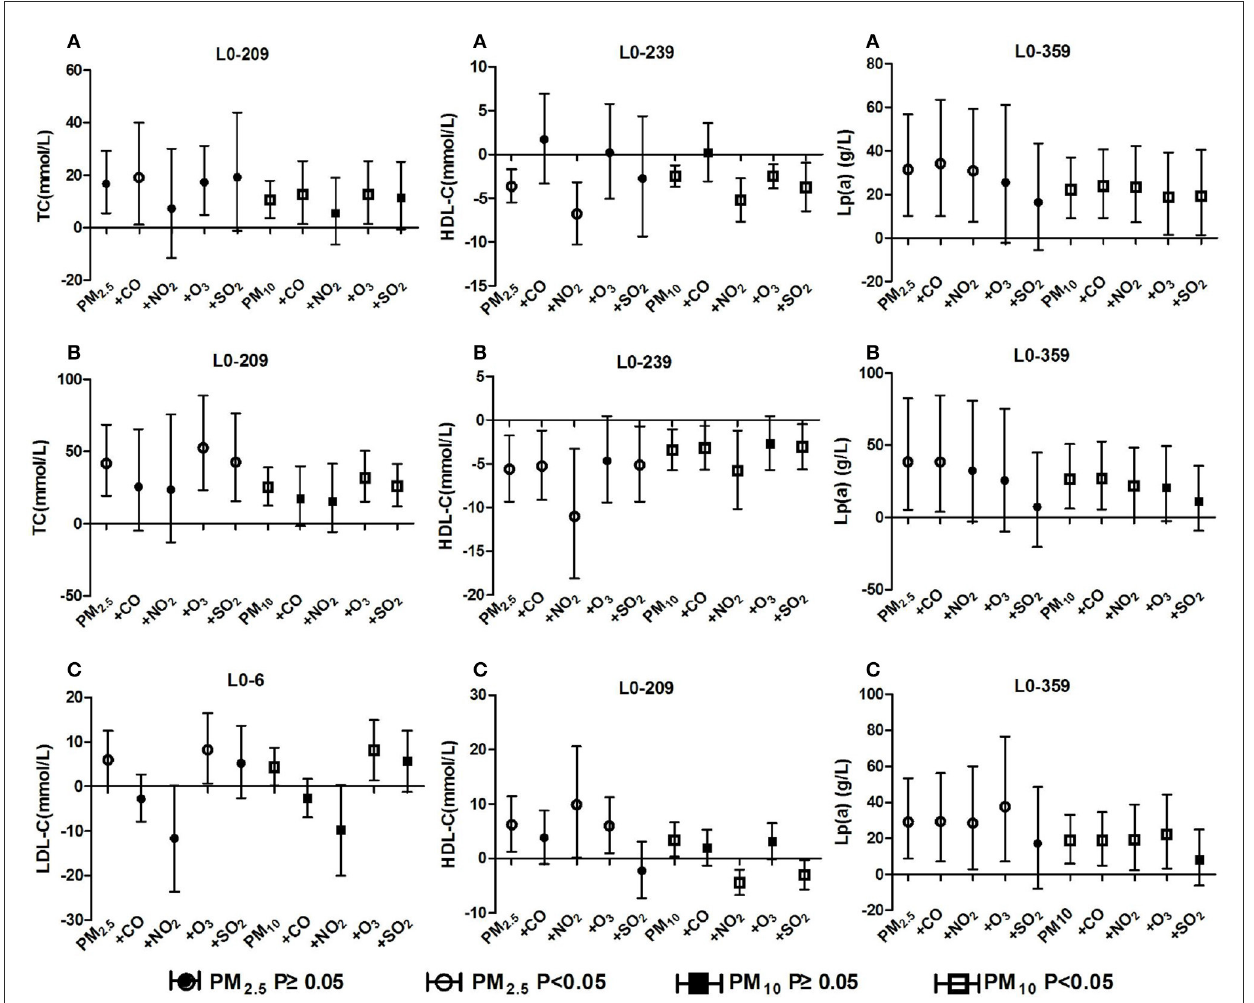
FIGURE6 Effect of ambient particulate matter on blood lipid after adjusting for gaseous pollutants. (A) Effect of ambient particulate matter on blood lipid after adjusting for gaseous pollutants in total hypertensive inpatients, (B) Effect of ambient particulate matter on blood lipid after adjusting for gaseous pollutants in hypertension inpatients with arteriosclerosis, (C) Effect of ambient particulate matter on blood lipid after adjusting for gaseous pollutants in hypertension inpatients without arteriosclerosis. + CO, + NO 2 , + O 3 , + SO 2 two-pollutant model after adjusting for the concentration of CO, NO 2 , O 3 , and SO 2